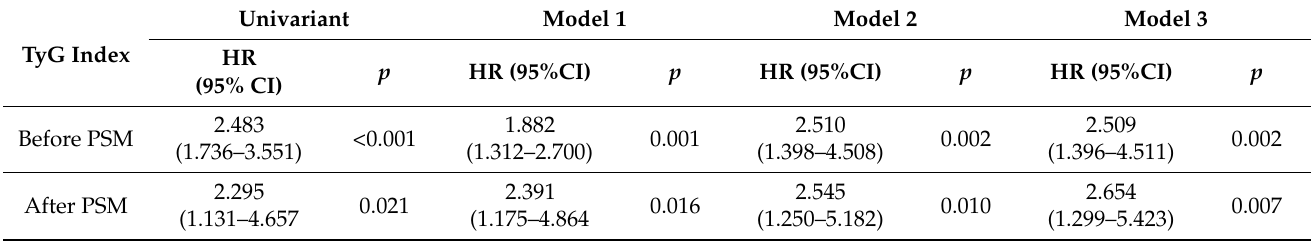
Figure 3. Kaplan ‒ Meier analysis for renal survival between the high TyG group and the low TyG group in the unmatched and matched cohorts. ( A ) The unmatched cohort and ( B ) the matched cohort. Abbreviation: PSM, propensity score match. Table 4. The Univariate and multivariate Cox proportional hazards regression models for composite endpoint in patients with IgAN in the unmatched and matched